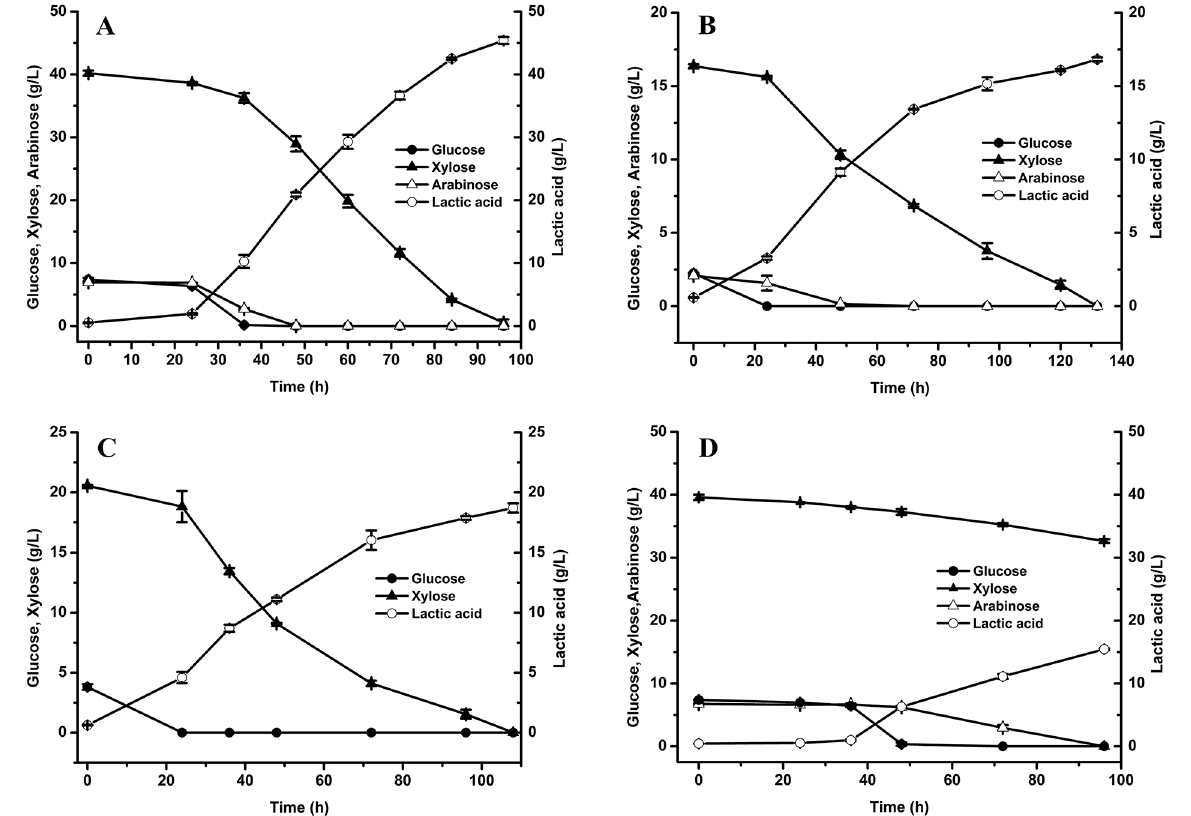
Fig 2. Lactic acid fermentation by B . coagulans GKN316 and B . coagulans NL01 from the three condensed hydrolysates. ( A ) B . coagulans GKN316, condensed acid-catalyzed steam-exploded hydrolysates (CASEH); ( B ) B . coagulans GKN316, condensed acid-catalyzed liquid hot water hydrolysate (CALH); ( C ) B . coagulans GKN316, condensed acid-catalyzed sulfite hydrolysate (CASH); ( D ) B . coagulans NL01, condensed acid-catalyzed steam- exploded hydrolysates (CASEH). Values are the average ± SD of three separate experiments.